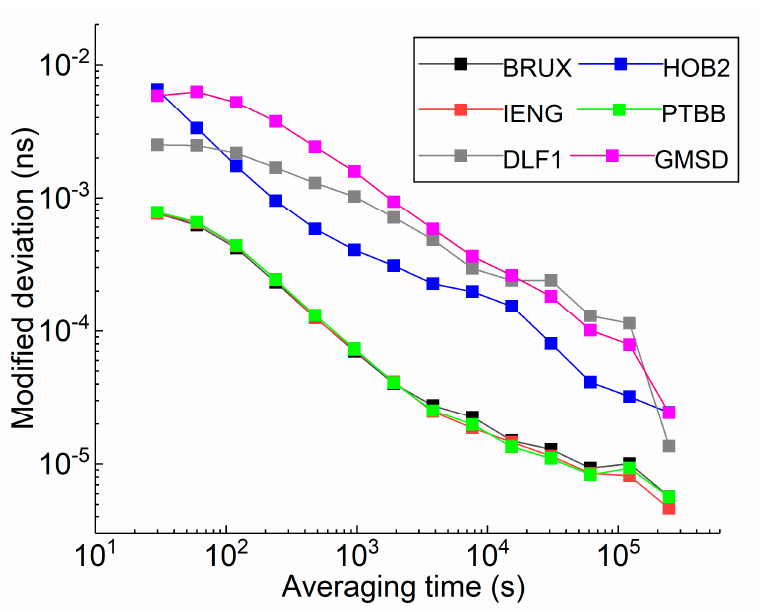
Figure 1. The modified deviation of a receiver clock offset estimated by GPS PPP estimation.